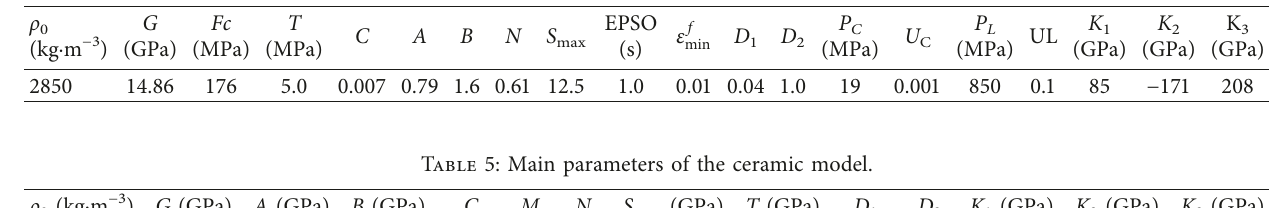
Table 4: RPC model parameters.